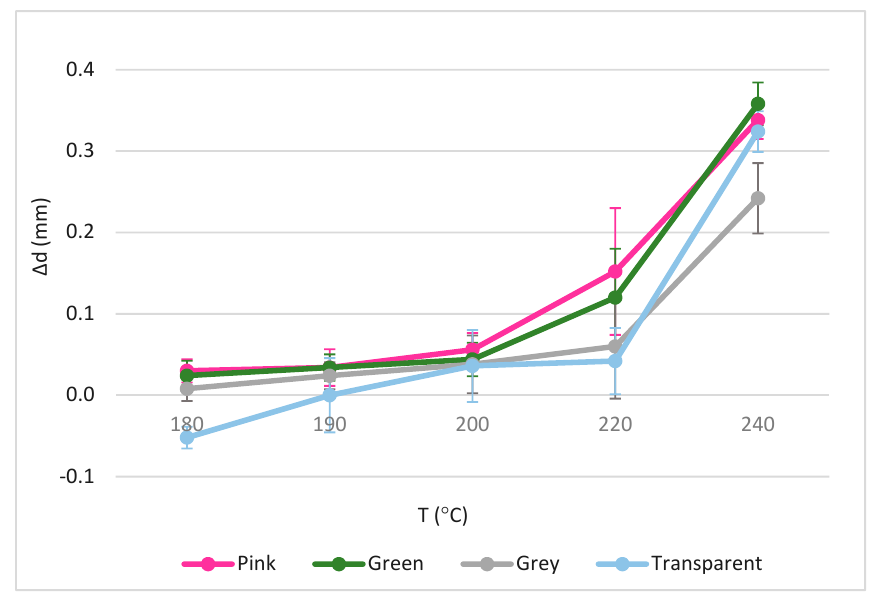
Figure 4. Dimensional deviations in relation to the used temperatures and pigments.